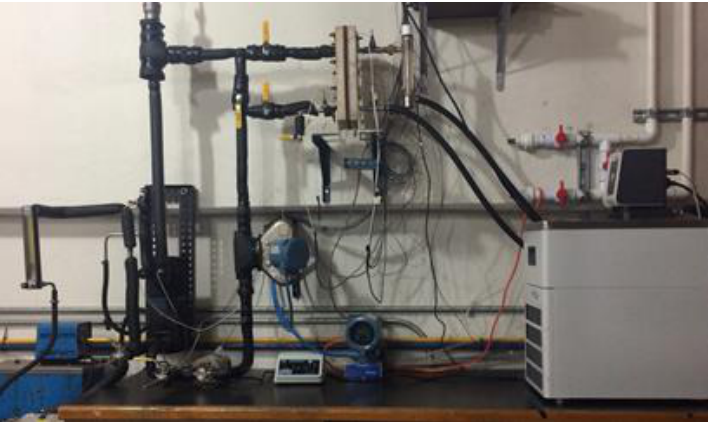
Figure 4. Experimental setup [25].